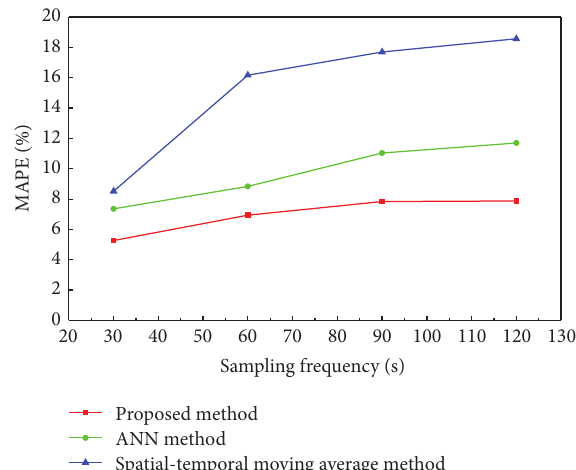
Figure 9: MAPE of the three methods at different sampling freq-